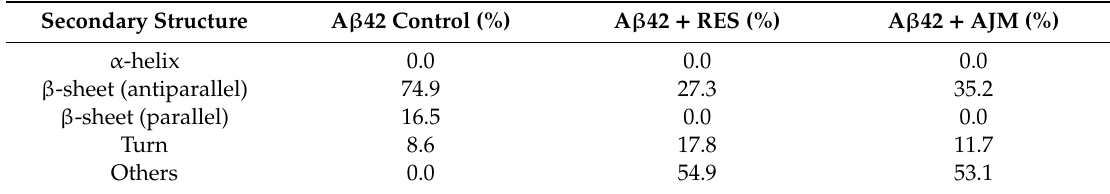
Table 3. Estimated secondary structure content (%) using BeStSel (Beta structure selection) software from CD spectra.